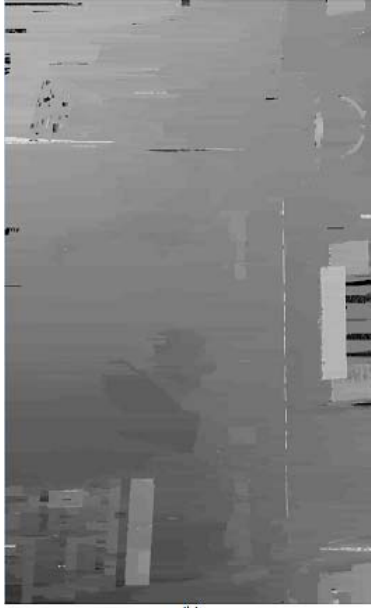
Figure2: Two DSIs calculated by the proposed algorithm. (a) is the DSI between Figure 1(a) and Figure 1(b), (b) is the DSI between Figure 1(c) and Figure 1(d). Figure 1(a) and Figure 1(c) are the reference images (Pixels’ gray value = reference pixel’s disparity * 4).